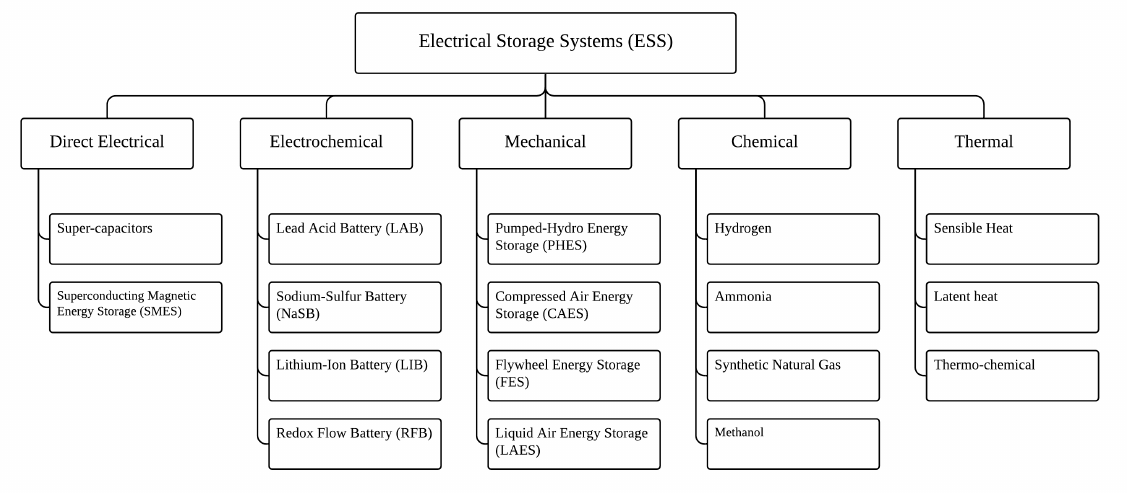
Figure 3. Types of Electrical Storage Systems based on the energy conversion interface. Adapted from